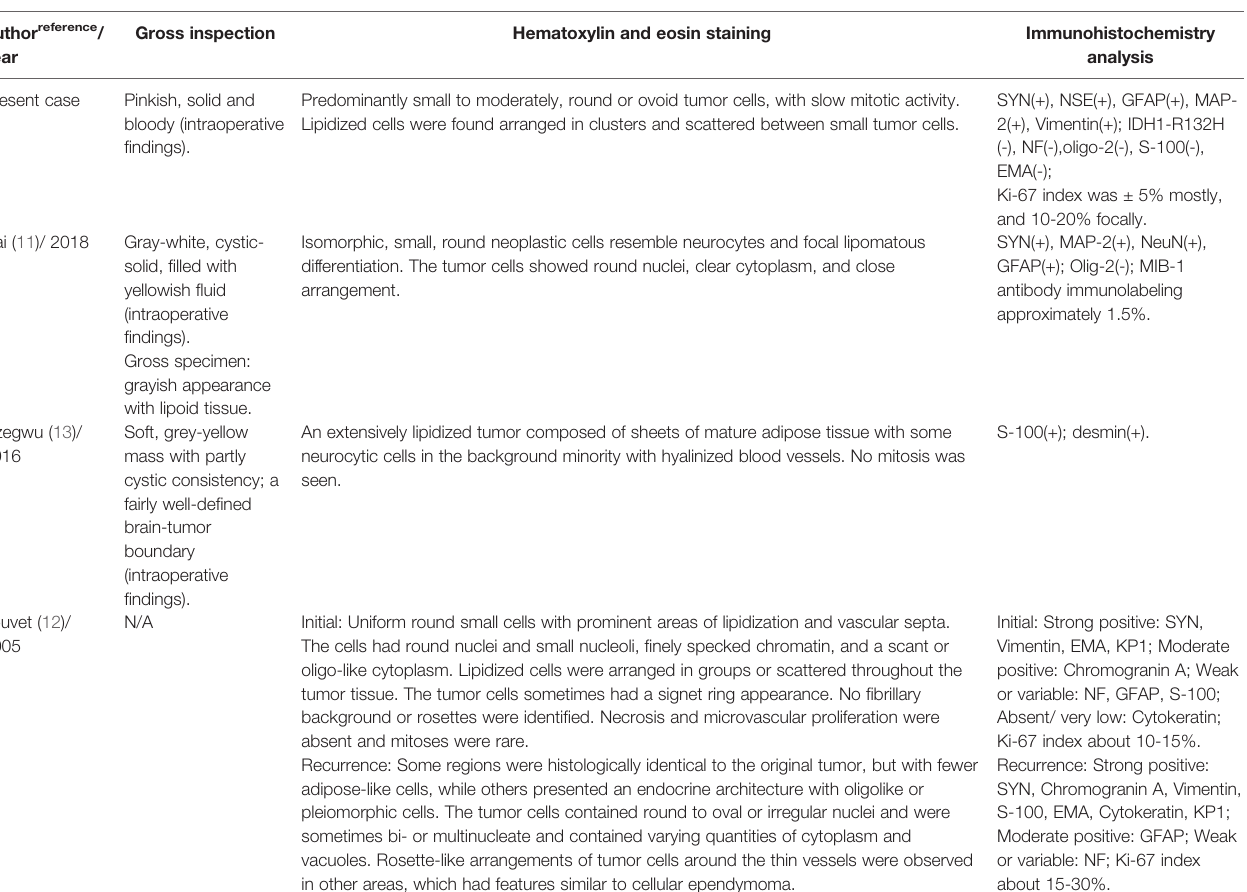
TABLE 2 | Pathological features of four pediatric patients with